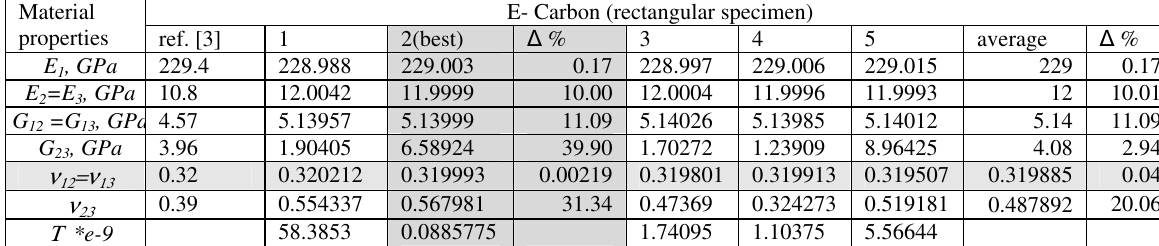
E- Carbon (rectangular specimen) Material